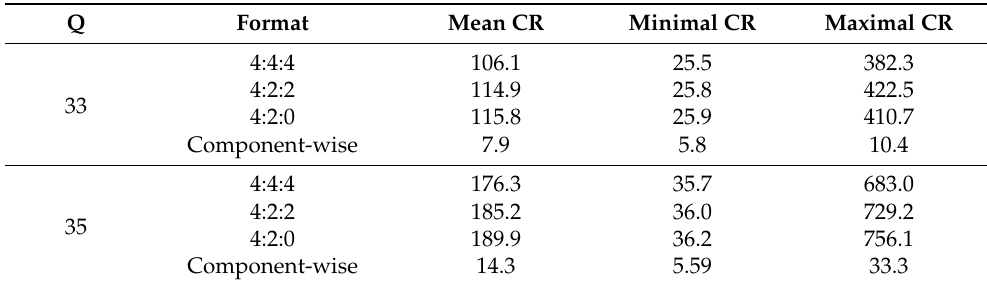
Table 7. Statistical data for comparison of compression variants’ performance characteristics